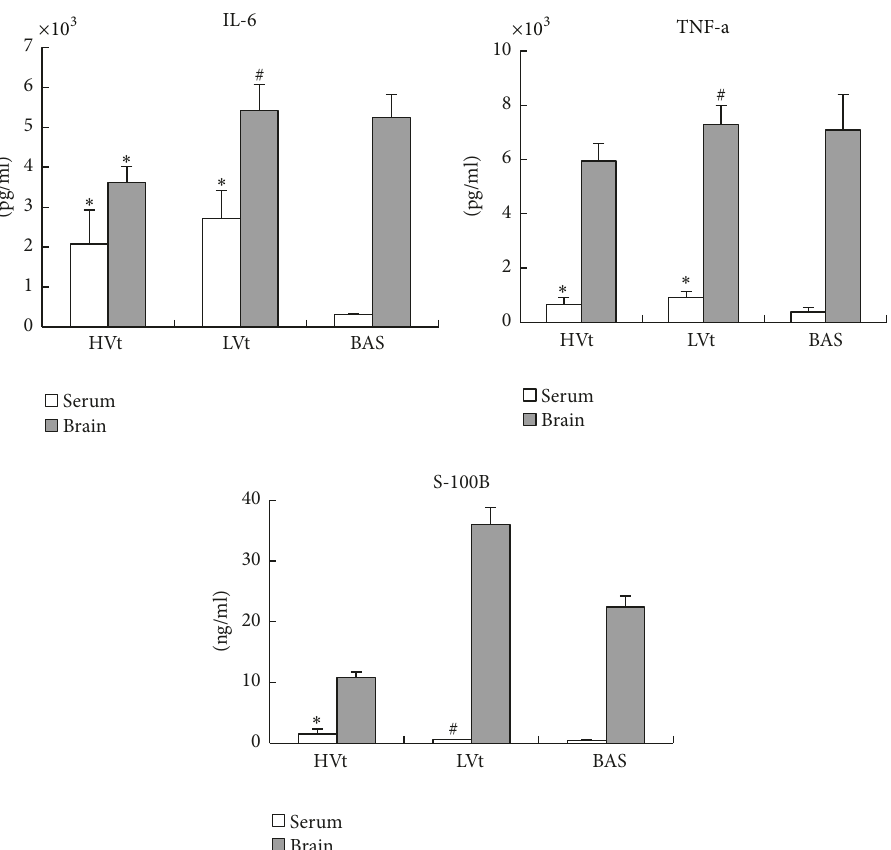
Figure 3: Cytokine concentrations in plasma and brain homogenates . MV increased plasma IL-6 and TNF- 𝛼 significantly, irrespective of the Vt level (LVt or HVt) ( 𝑃 < 0.013 ). In the brain, IL-6 and TNF- 𝛼 decreased in the HVt group. There was no difference in IL-6 and TNF- 𝛼 levels between the LVt and basal groups. In the plasma, S-100B increased significantly in the HVt group. In brain, no correlation between S100B levels and tidal volume levels was seen. Results are presented as the mean ± SD. ∗ 𝑃 < 0.013 versus the basal group and # 𝑃 < 0.013 versus the HVt group. 𝑁 = 8 animals per group. MV, mechanical ventilation; BAS, basal; LVt, low tidal volume; HVt, high tidal